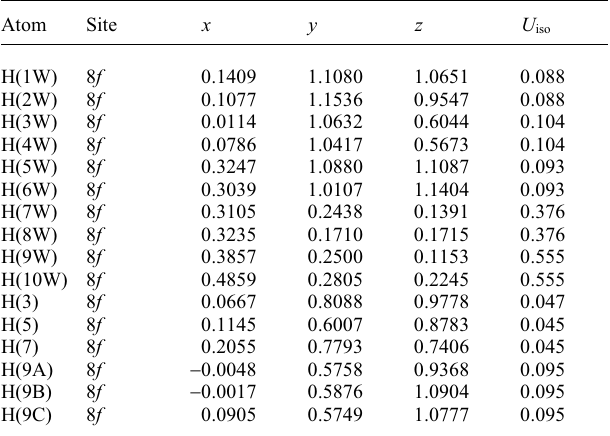
Table 2. Atomic coordinates and displacement parameters (in Å 2 )